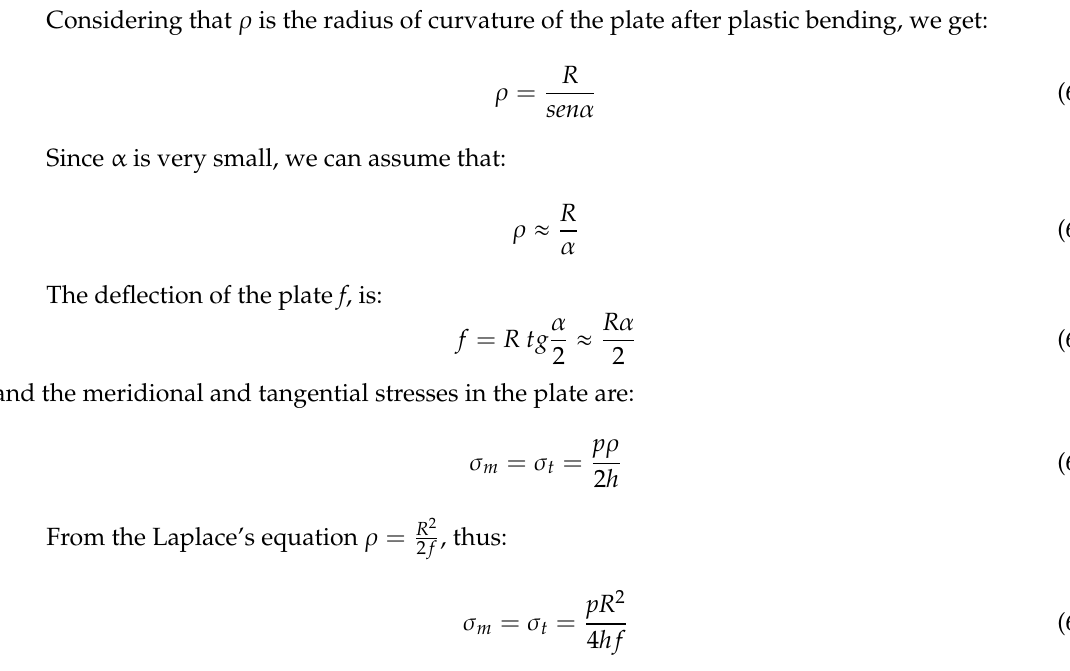
Figure 7. Scheme of the flat plate after being subjected to the load.